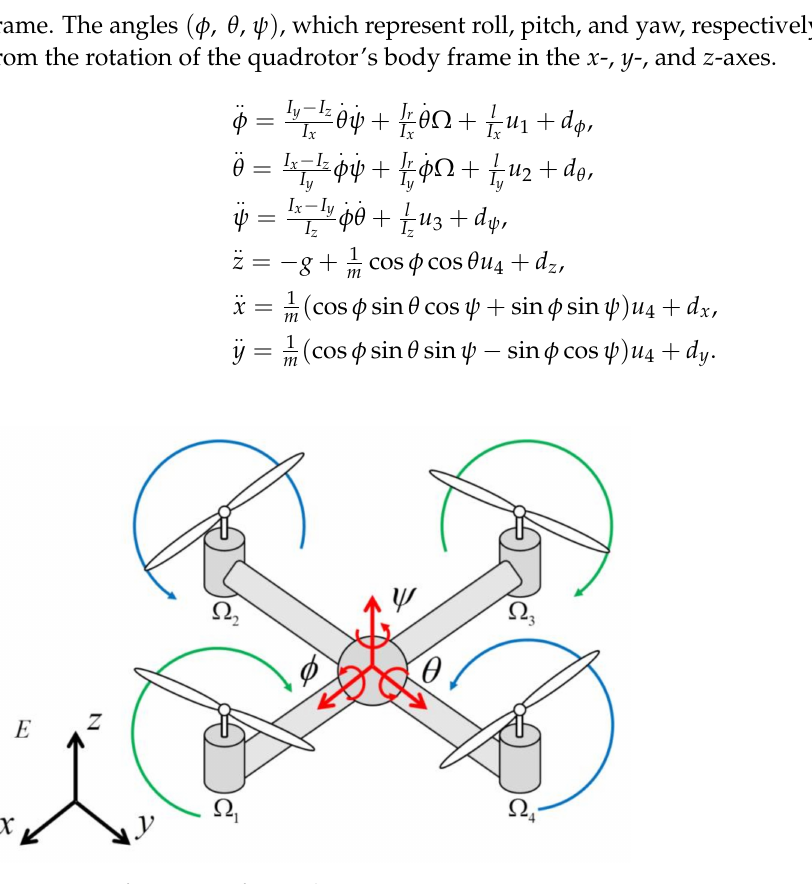
Figure 1. Configuration of a